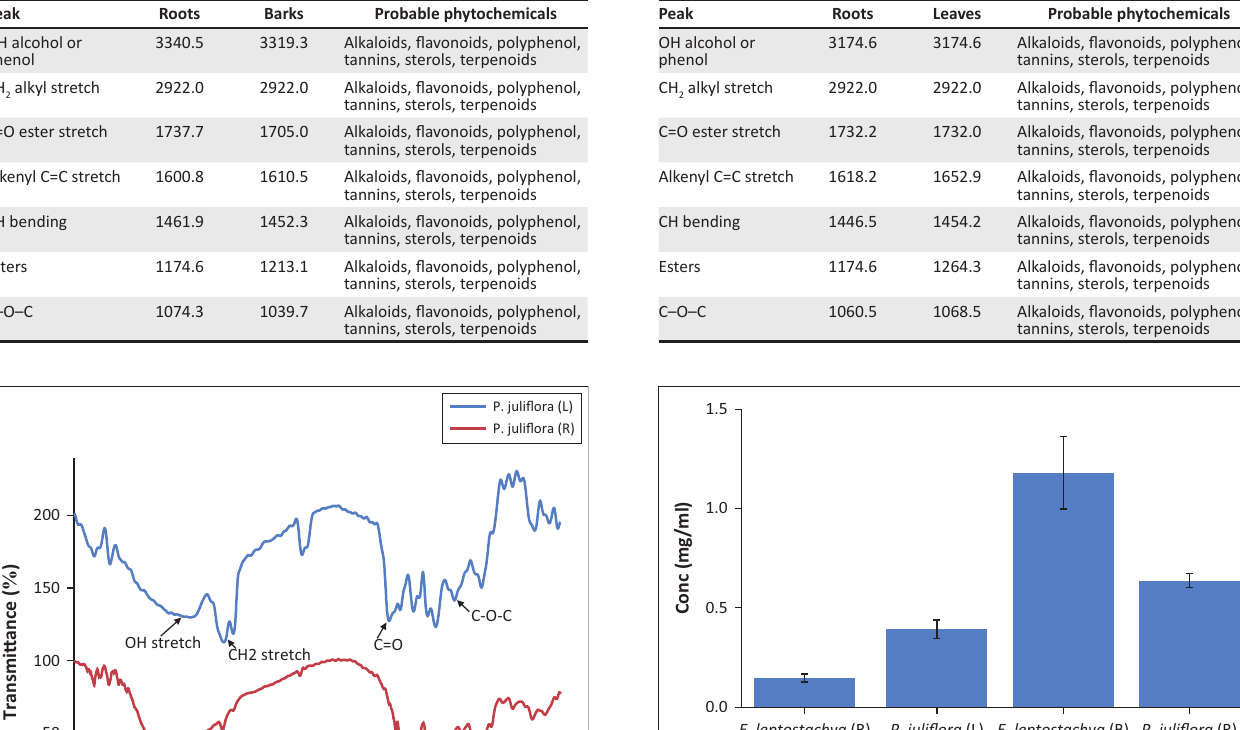
E. leptostachya (R) P. juliflora (L) E. leptostachya (B) P. juliflora